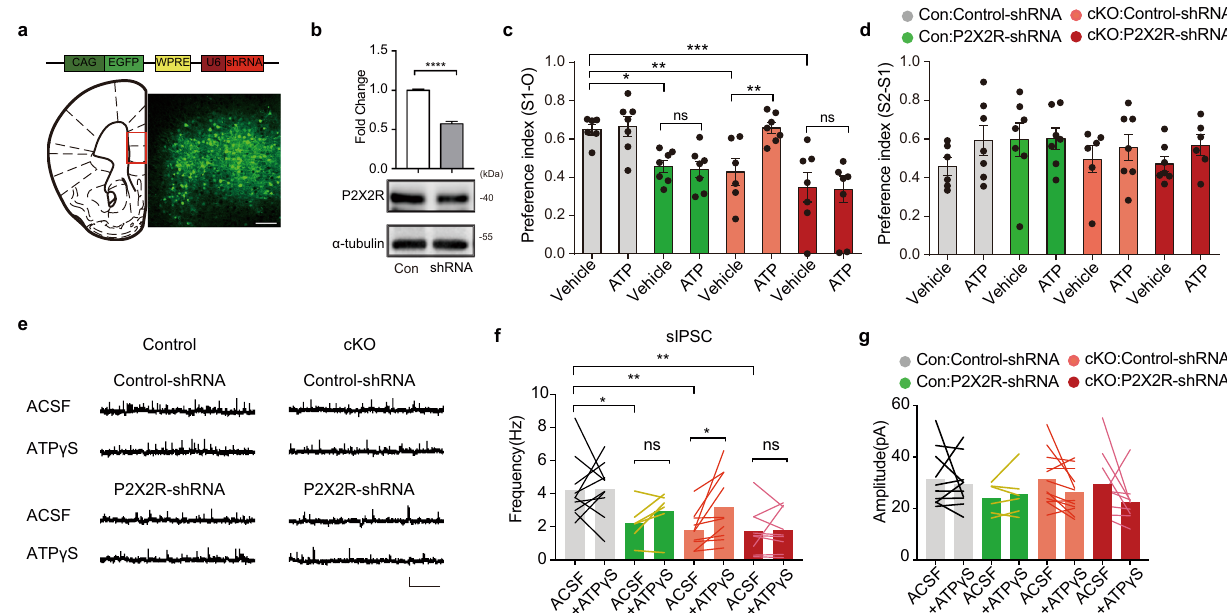
Fig. 5 P2X2 receptors in the prefrontal cortex mediate the bene fi cial effects of ATP on ASD-like behaviors. a A schematic of the AAV vector carrying P2X2R-shRNA (top). The viral expression of P2X2R-shRNA (bottom right) and the injection site in the mPFC (bottom left, red box, scale bar: 100 µ m). b Western blot showing P2X2R knockdown in the mPFC with AAV-P2X2R-shRNA (two-tailed unpaired t -test, t 6 = 12.71, P = 0.15 × 10 − 4 , n = 4). c , d i.p. injection of ATP (125 mg/kg) rescued social interaction in IP3R2 cKO mice, and this effect was blocked by P2X2R knockdown ( c F 7,45 = 6.973, P = 0.7 × 10 − 5 ; Con:Control-shRNA Con:P2X2R-shRNA P = 0.0142; Con:Control-shRNA cKO:Control-shRNA P = 0.0066; Con: vehicle vs. vehicle , vehicle vs. vehicle , Control-shRNA vehicle vs. cKO:P2X2R-shRNA vehicle , P = 0.0002; Con:P2X2R-shRNA vehicle vs. Con:P2X2R-shRNA ATP , P = 0.8171; cKO:Control-shRNA vehicle vs . cKO: Control-shRNA P = 0.0037; cKO:P2X2R-shRNA . cKO:P2X2R-shRNA P = 0.8931; d F = 0.8109, P = 0.5830; n = 6,7,7,7,6,7,7,7). e sIPSC ATP , vehicle vs ATP , 7,45 recordings with and without ATP γ S (25 µ M) treatment in mPFC layer 5 pyramidal neurons from control and IP3R2 cKO mice injected with control-shRNA or P2X2R-shRNA. f , g Bar graphs showing sIPSC frequency ( f Con:Control-shRNA ACSF vs. Con:P2X2R-shRNA ACSF , two-tailed unpaired t -test, t 14 = 2.381, P = 0.0320, n = 10/6; Con:Control-shRNA ACSF vs. cKO:control-shRNA ACSF , two-tailed unpaired t -test, t = 3.539, P = 0.0023, n = 10; Con:Control-shRNA ACSF 18 vs. cKO:P2X2R-shRNA ACSF , two-tailed unpaired t -test, t 17 = 3.273, P = 0.0045, n = 9/10; Con:P2X2R-shRNA ACSF vs. Con:P2X2R-shRNA ATP γ s , two-tailed paired t -test, t = 2.001, P = 0.1018, n = 6; cKO:Control-shRNA ACSF vs. cKO:Control-shRNA ATP γ s , t wo-tailed paired t -test, t = 2.777, P = 0.0215, n = 10; cKO:P2X2R- 5 9 shRNA cKO:P2X2R-shRNA t -test, t = 0.1624, P = 0.8750, n = 9) and amplitude ( g ) with or without ATP γ S (25 µ M) treatment ACSF vs. ATP γ s , two-tailed paired 8 in mPFC layer 5 pyramidal neurons from control and IP3R2 cKO mice injected with control-shRNA or P2X2R-shRNA. P2X2R knockdown prevented the enhancing effect of ATP γ S (25 µ M) on sIPSC frequency in IP3R2 cKO slices. Scale bars: 20 pA, 2 s. Each data point represents an individual mouse ( c , d ). Data are presented as the mean ± SEM. * P < 0.05, ** P < 0.01, *** P < 0.001, **** P < 0.0001. ns, no signi fi cant difference. One-way ANOVA with Fisher ’ s LSD multiple comparison post hoc test ( c , d ). Source data are provided as a Source data fi